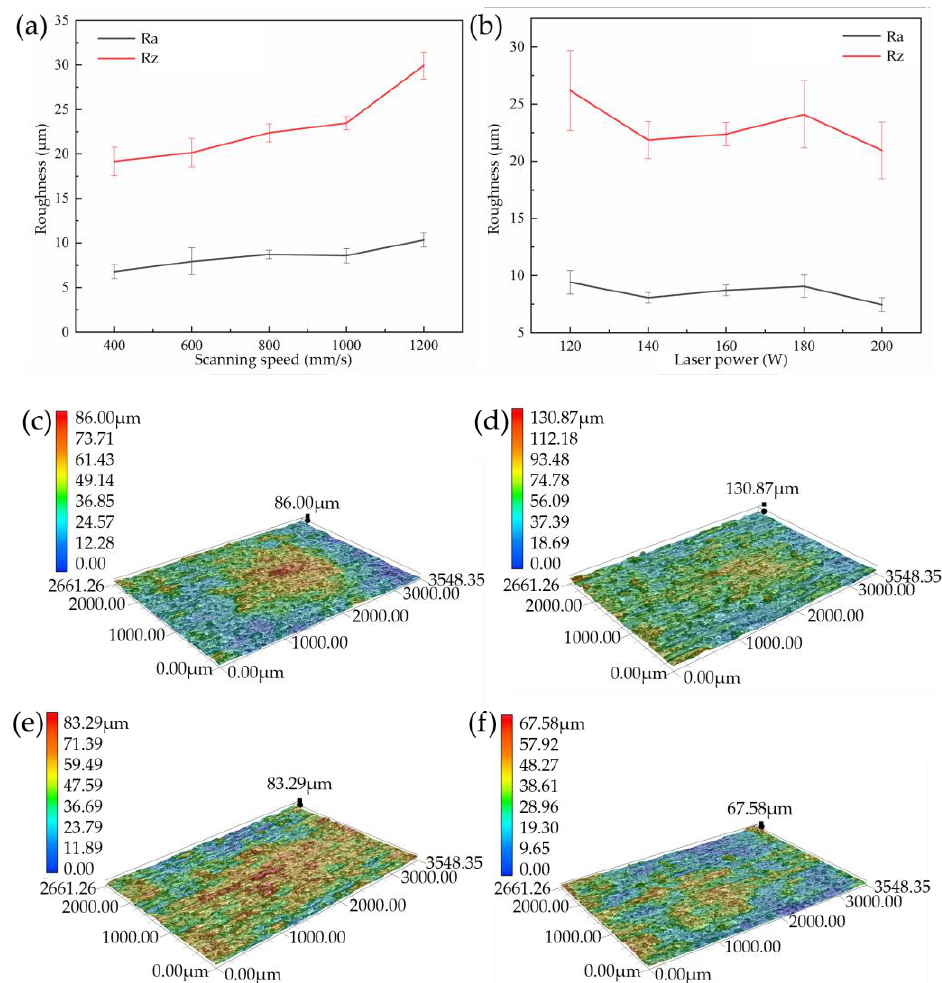
Figure 8. Morphology and roughness of upper side under different parameters: ( a ) scanning speed; ( b ) laser power; ( c ) 160 W, 400 mm/s; ( d ) 160 W, 1200 mm/s; ( e ) 120 W, 800 mm/s; ( f ) 200 W, 800 mm/s.